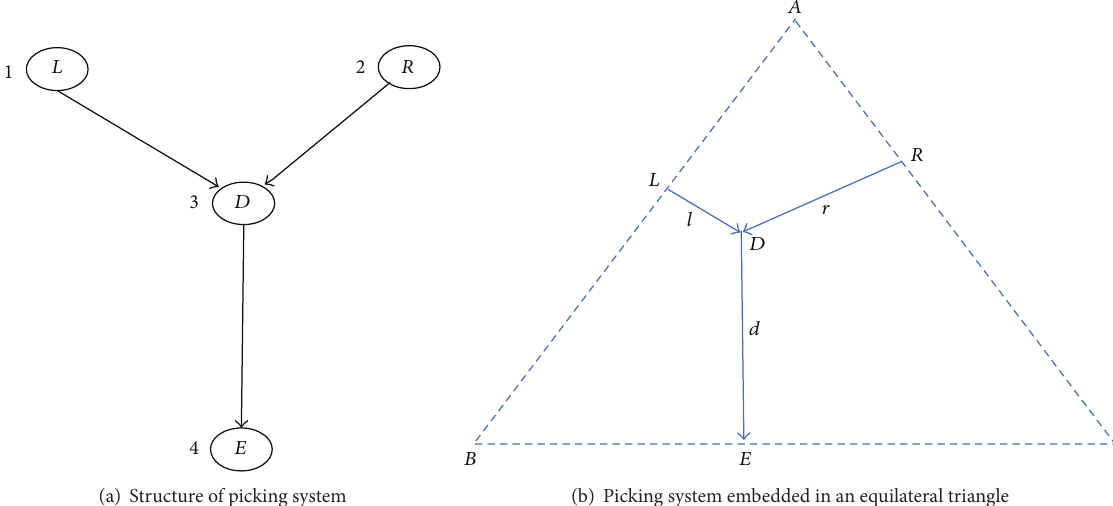
Figure 1: A two-truck bucket brigade tree-shaped picking